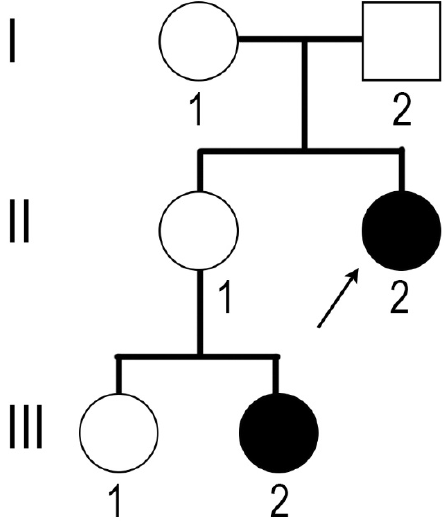
Figure 1. Genealogy of the family. Black symbols denote individuals with clinical features of com- plete androgen insensitivity syndrome (CAIS). I–III denote the generations; numbers 1, 2 reflect the order of birth in the family; arrow marks the patient discribed in the case report.